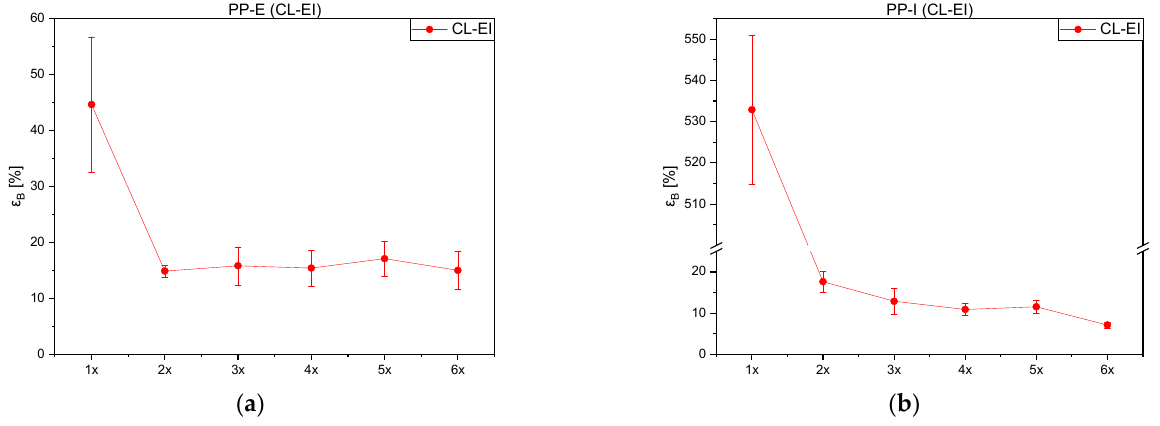
Figure 9 . Strain at break values over the course of the processing loops of ( a ) PP-E, and ( b ) PP-I.